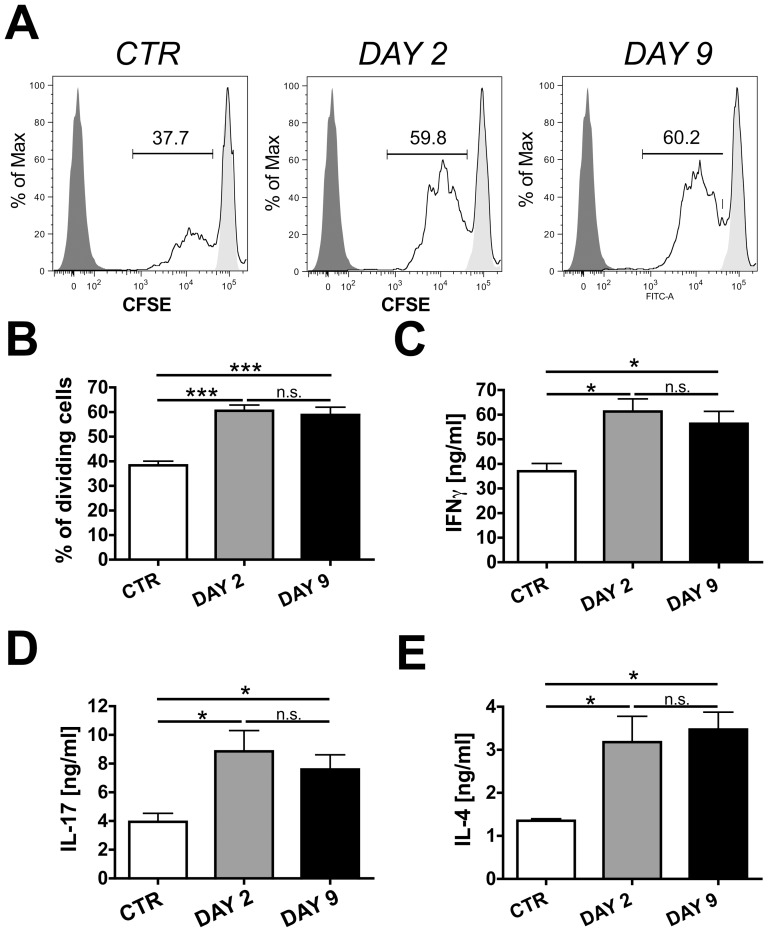
DCs isolated from LNs draining CHS-inflamed skin of WT mice are more potent inducers of T-cell activation in vitro.CD11c+ DCs were FACS-sorted from the auricular LNs of WT BALB/c mice with uninflamed (CTR) or DAY 2- or DAY 9-inflamed ear skin. Subsequently, CFSE-labeled TCR transgenic CD4+ T cells isolated from DO11.10 mice were incubated for 3 days with DCs and OVA peptide at a T cell: DC ratio of 5:1. CFSE dilution assays revealed that DCs isolated from LNs draining DAY 2- and DAY 9-inflamed skin were significantly more potent in inducing T cell proliferation than DCs isolated from control LNs. (A) Representative FACS plots showing CFSE dilution in dividing T cells. Numbers indicate the percentage of gated cells. (B) Quantification of the percentage of proliferating T cells. Significantly higher levels of (C) IFNγ, (D) IL-17 and (E) IL-4 were quantified in the supernatant of co-cultures containing DCs isolated from LNs draining DAY 2- or DAY 9-inflamed skin. Representative data from 1 out of 2 similar experiments (n = 3) per condition are shown. *p<0.05.